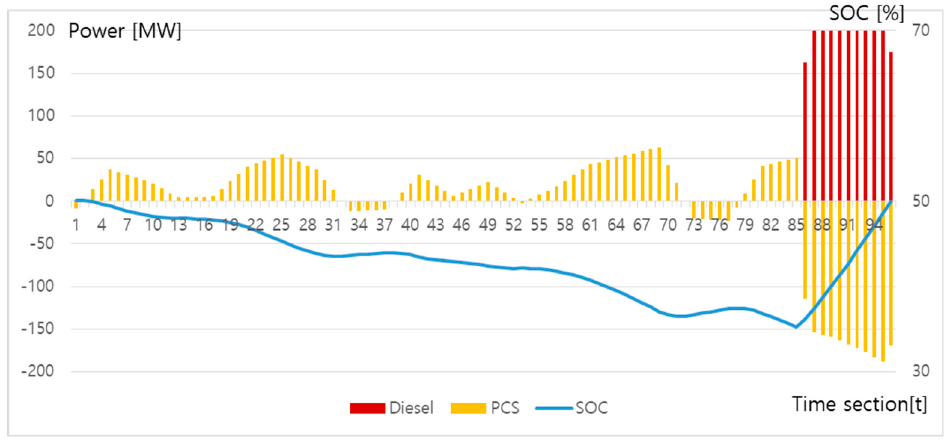
Figure 5. Simulation result from Case 1.